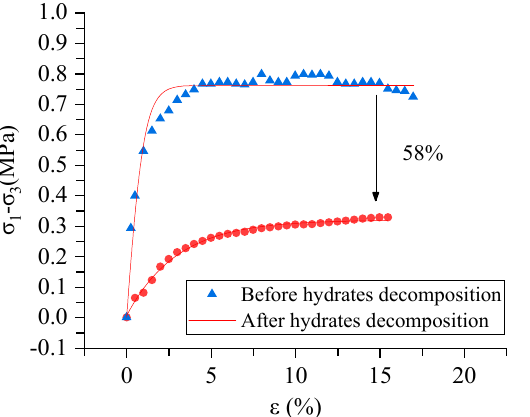
Figure 11. Comparison of HBS shear strength before and after hydrate dissociation.